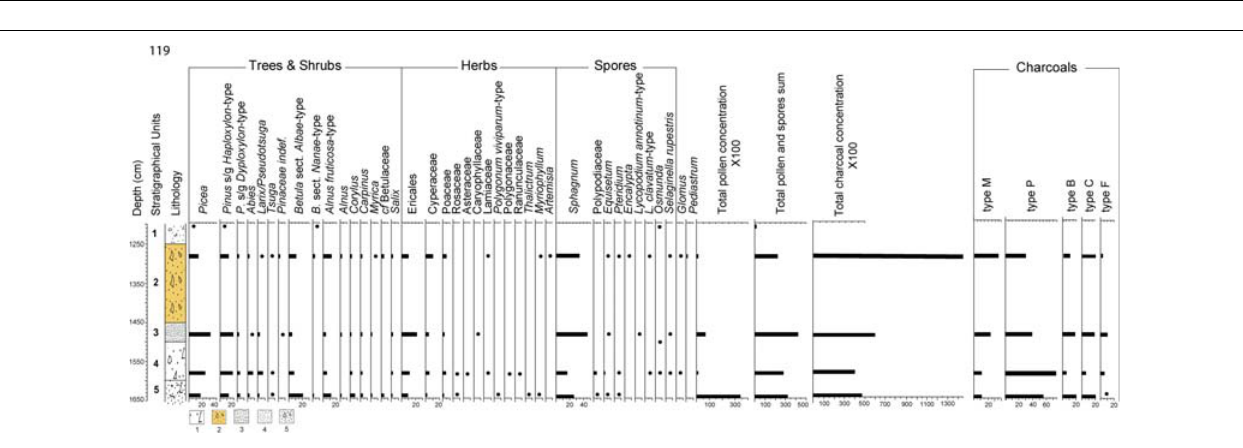
FIGURE 4 | Percentage pollen, spore, non-pollen-palynomorph and charcoal diagram of site 119 (for location see Figure 1B ). 1 – grayish-green sandy pebble bed; 2 – pebble bed and fine sandy loam with boulders, stones and layers of impact glasses (chaotic horizon); 3 – fine-grained sand with lignite layers and lenses; 4 – grayish-brown pebble bed with coarse sand; 5 – gray-blue ignimbrite